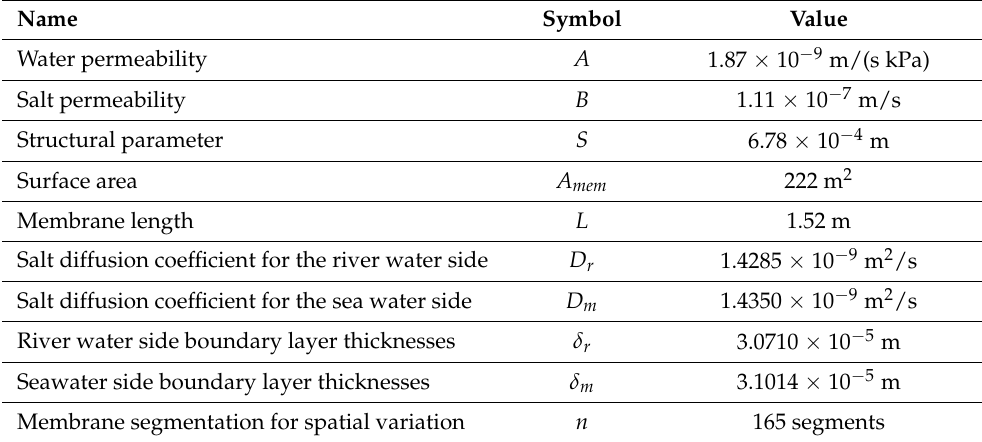
Table A4. Parameters for any of the stack membrane modules.